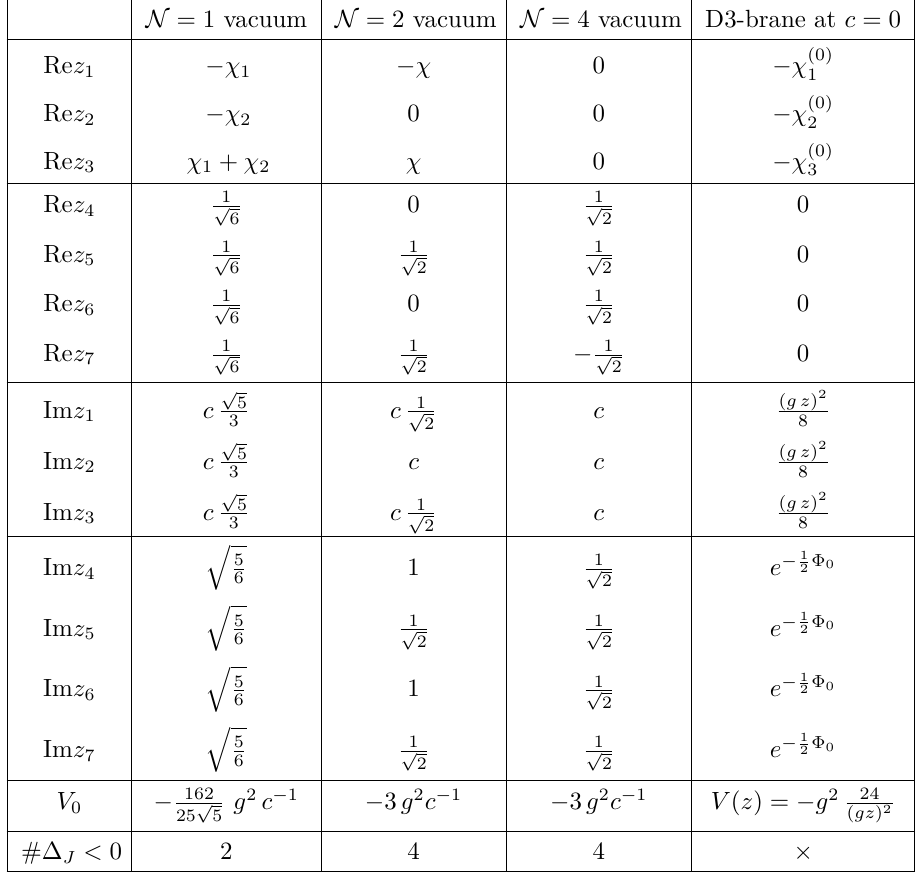
Table 1 . Summary of the AdS 4 supersymmetric vacua with the largest possible residual symmetry within their respective families. The VEVs of z and the values of the scalar potential at the vacua i are provided. In the last line, #∆ 0 denotes the number of dual irrelevant operators at each J < such